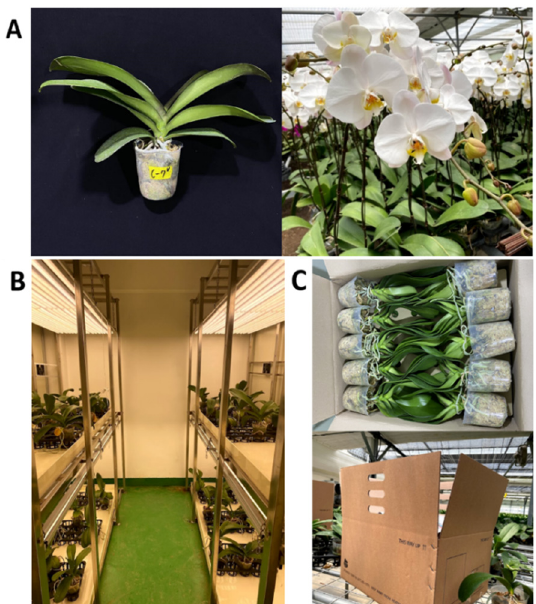
Figure 1. ( A ) Phalaenopsis Sogo Yukidian ‘V3 used in the experiment. ( B ) Simulated shipping under light conditions. ( C ) Paper-box packaging for simulated shipping under dark conditions.